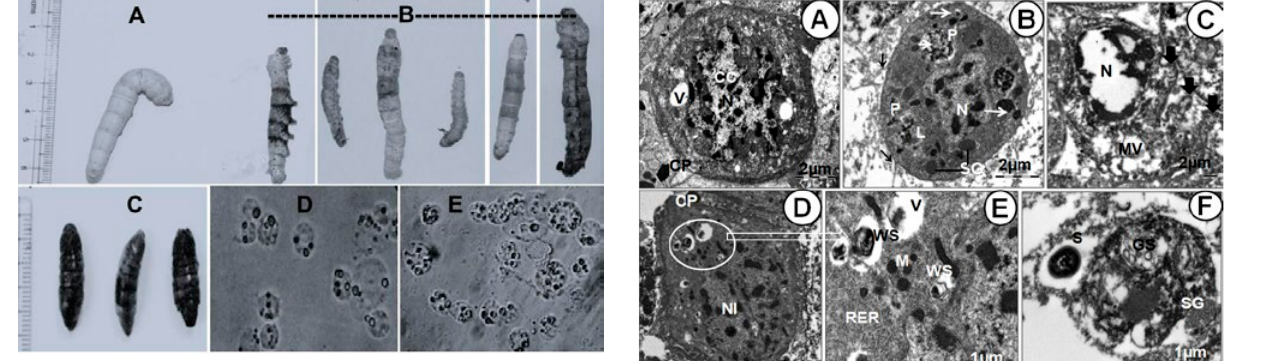
Figure 1. Organismal effects of microsporidian infection on B. mori larva: In comparison to control larva (A), infected larvae showed retarded growth and both larvae and pupae melanised (B – C). Control larval hemocytes illustrate clear cytoplasm and less gran- ules (D) whereas infected larval hemocytes were with granulated cytoplasm and few showed degranulation (E).